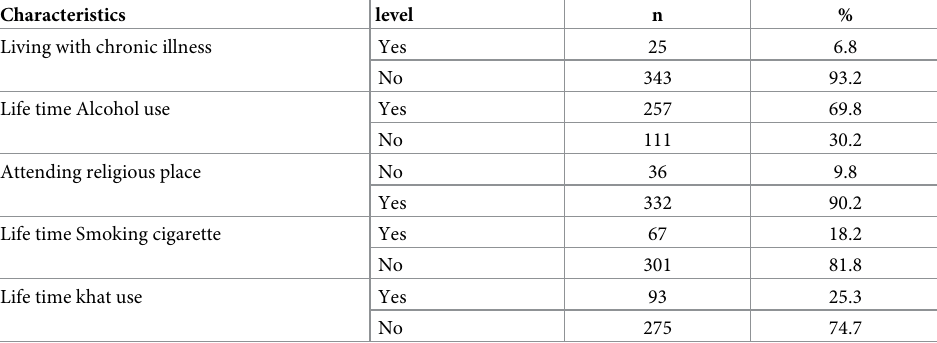
Table 2. Behavioural and clinical characteristics percentage distribution of the of prisoners in Wollega zones of Oromia, Ethiopia, 2019.